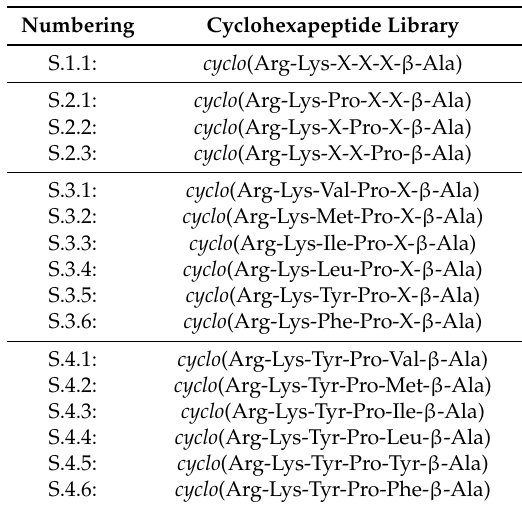
Table 1. List of sublibraries of cyclohexapeptides used in the deconvolution process. X stands for one of the 18 of the common L - α -amino acids except cysteine and tryptophan. Reprinted with permission from [45]. Copyright (1998) American Chemical Society.